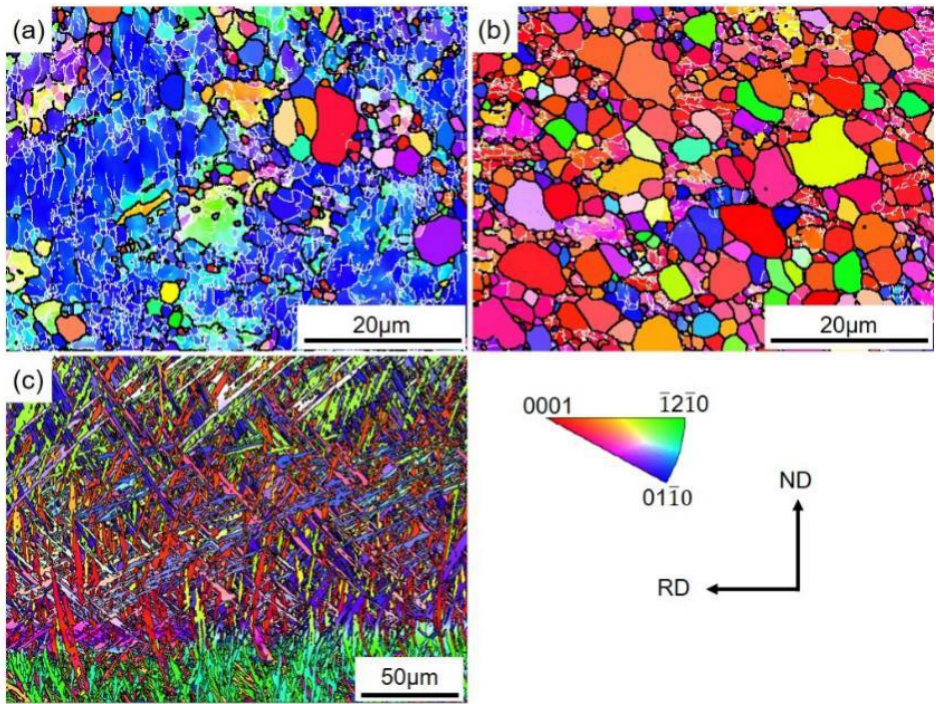
Figure 7. SEM-EBSD IPF maps of Ti-6Al-4V alloy deformed by 90% at different temperatures: ( a ) 850 °C, ( b ) 950 °C, ( c ) 1100 °C.